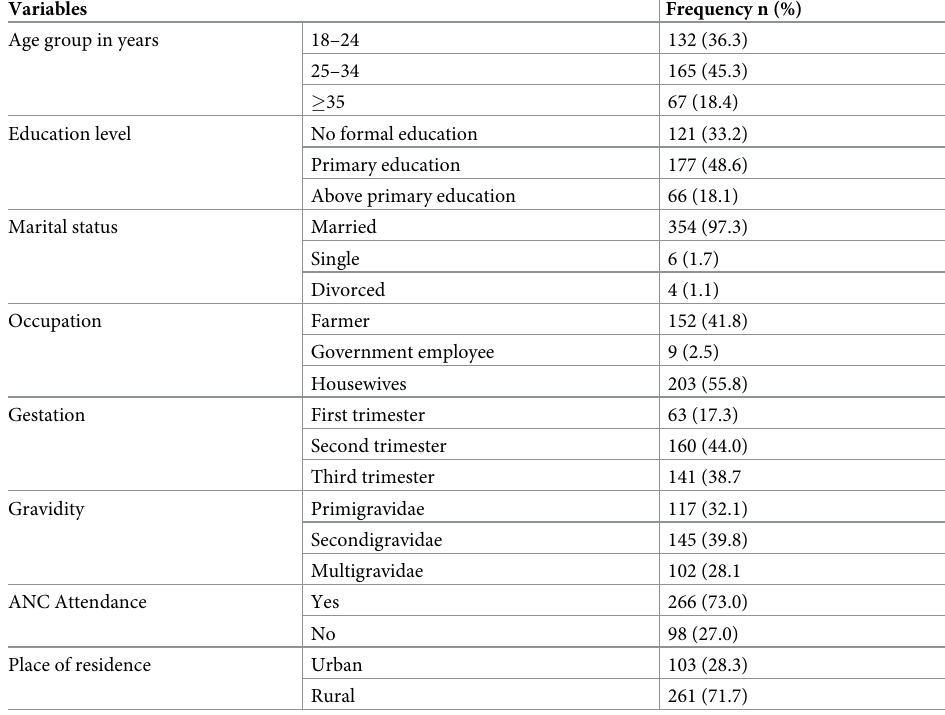
Table 1. Sociodemographic and obstetric characteristics of the study participants, Merti district, Southeastern Oromia, March to September 2018 (N =